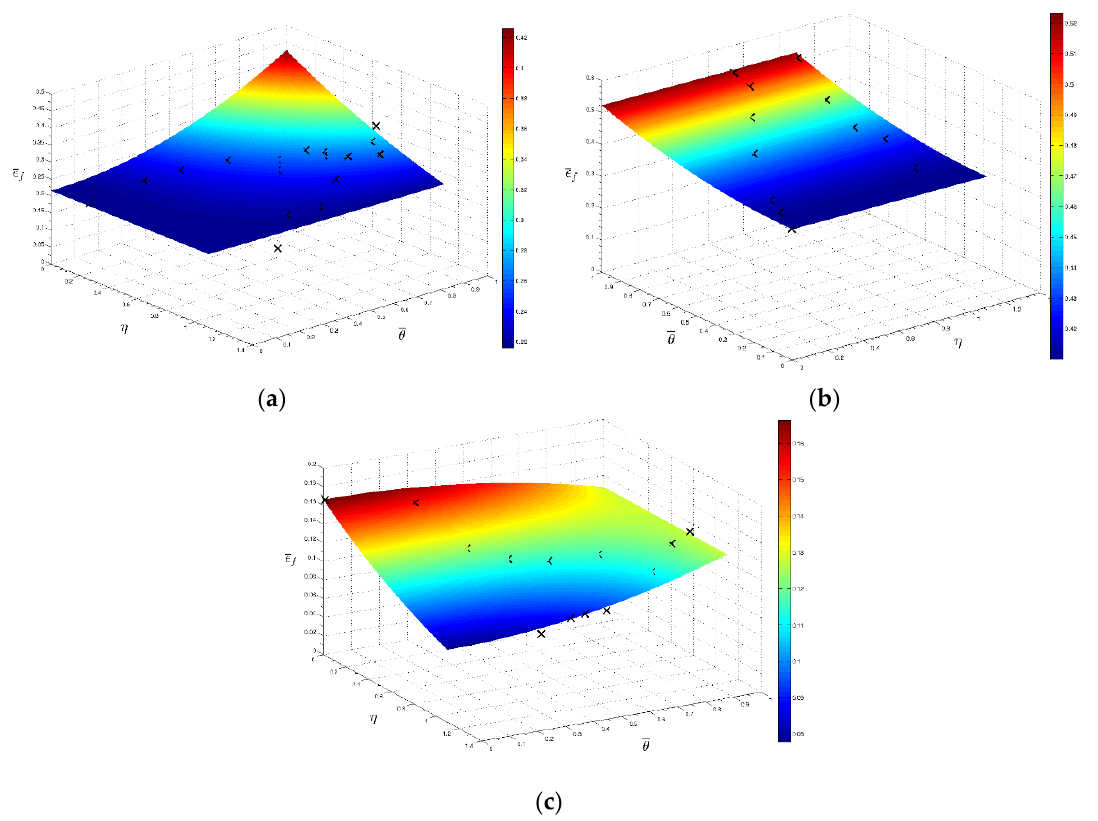
Figure 7. 3D plot of strain failure versus stress triaxiality and Lode parameter for: ( a ) AA 2024 ‐